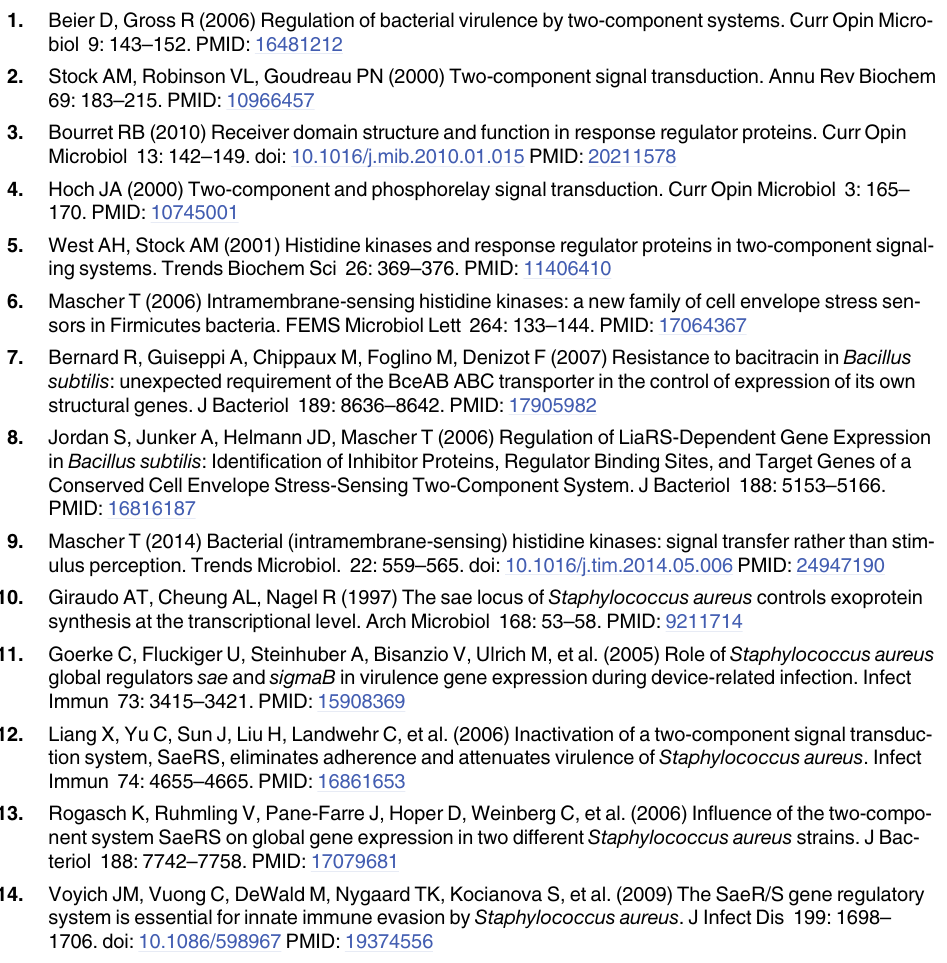
S1 Table. Bacterial strains and plasmids used in this study. S2 Table. Oligonucleotides used in this